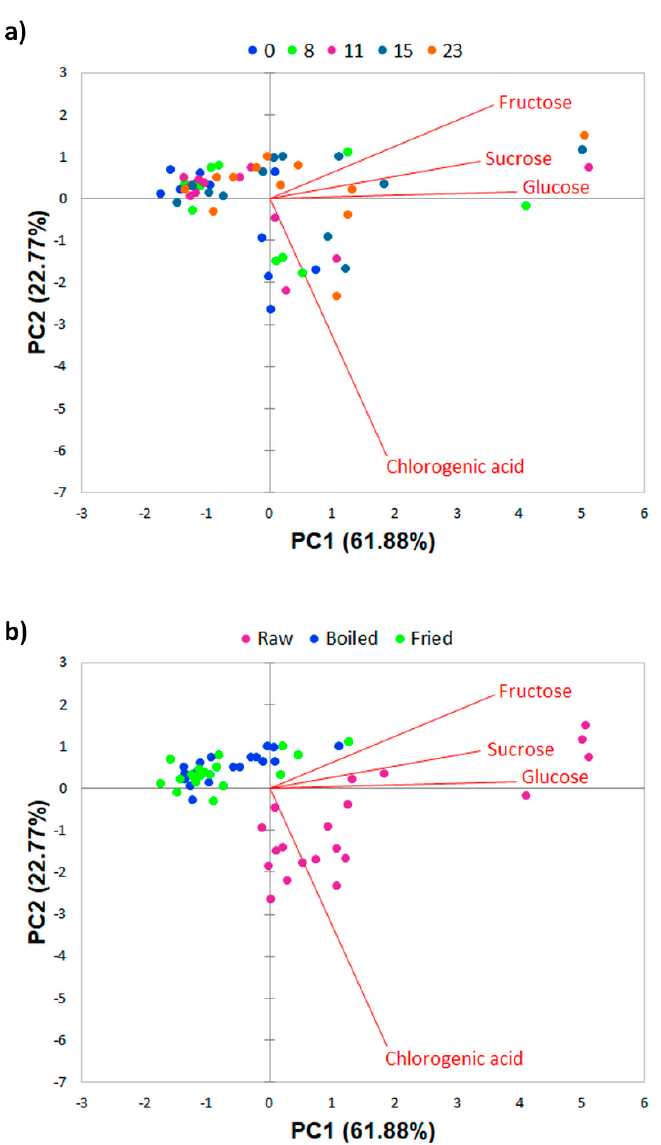
Figure 1. Distribution of UV-C untreated and treated fresh-cut potatoes in two-dimensional coordi- nate system defined by the first two principal components (PC1 and PC2) in relation to the ( a ) storage days and ( b ) cooking method.